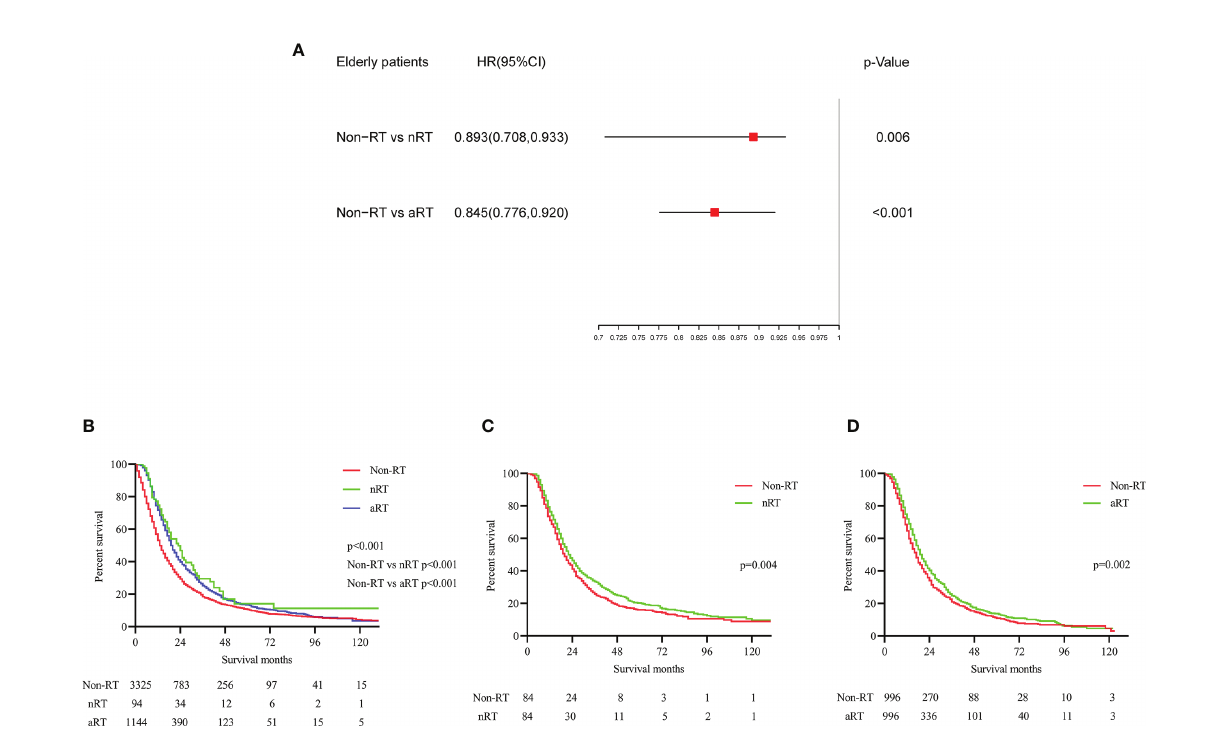
FIGURE 4 | The forest plot and the survival curves were used to demonstrate the effect of radiotherapy in elderly stage IIB/III PDAC patients. (A) . The forest plot for non- RT vs. nRT and non-RT vs. aRT in elderly stage IIB/III PDAC patients; (B) . The survival curve for total elderly stage IIB/III PDAC patients before PSM; (C) . The survival curve for non-RT vs. nRT in elderly stage IIB/III PDAC patients after PSM; (D) . The survival curve for non-RT vs. aRT in elderly stage IIB/III PDAC patients after